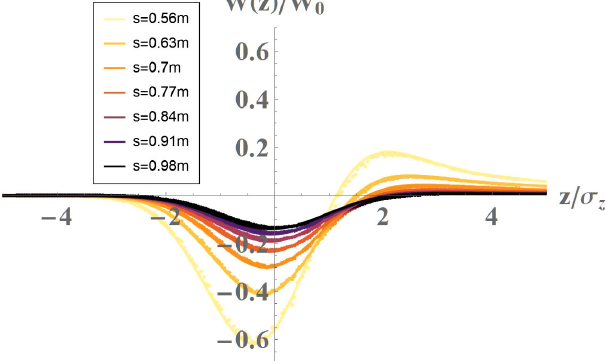
FIG. 11. Evolution of W ð z Þ inside drift D1 in beamline A. The curves are theory prediction using Eq. (104), and the dots are from Bmad simulation.